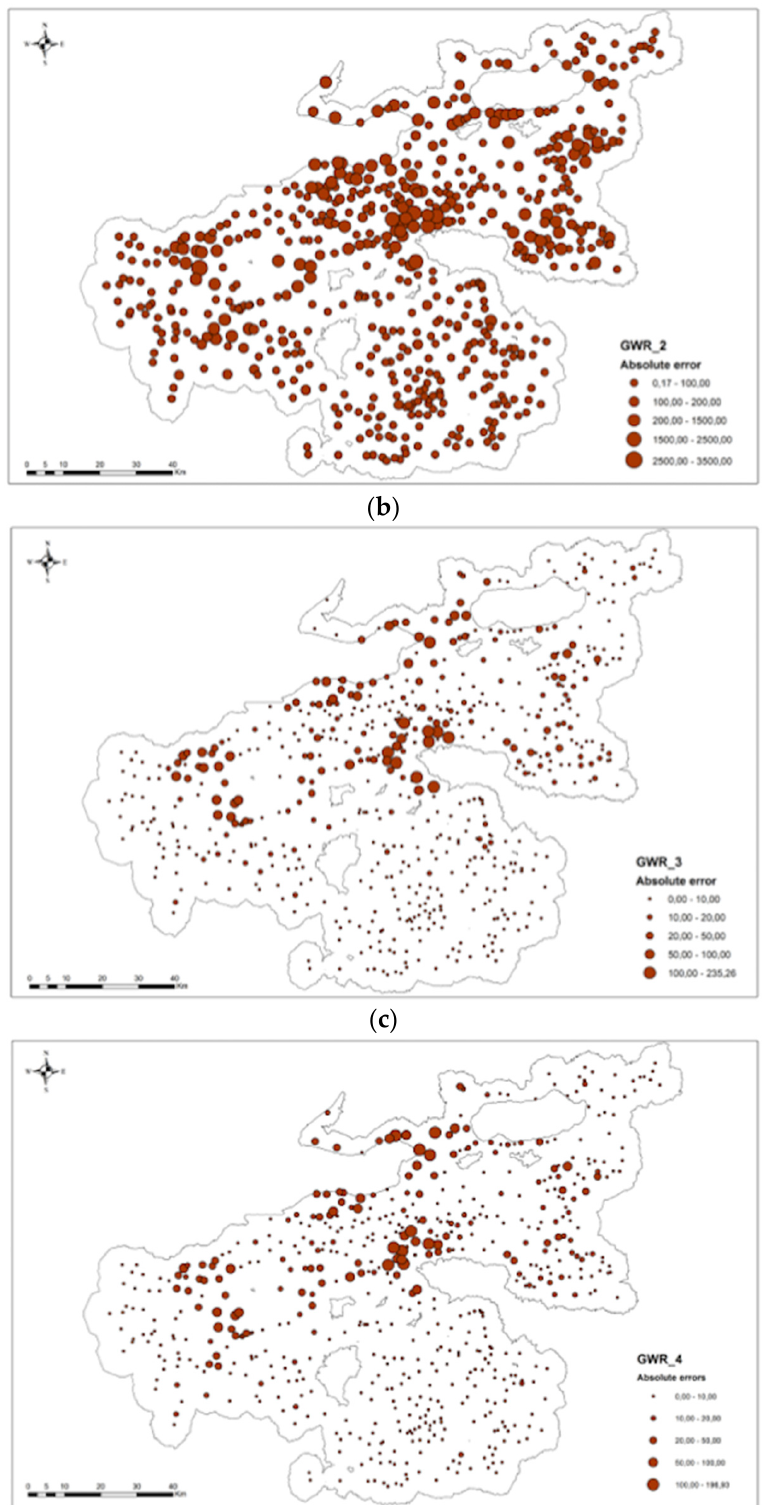
Figure 10. Comparison of absolute errors across different GWR model including ( a ) GWR_1; ( b ) GWR_2; ( c ) GWR_3; and ( d ) GWR_4.